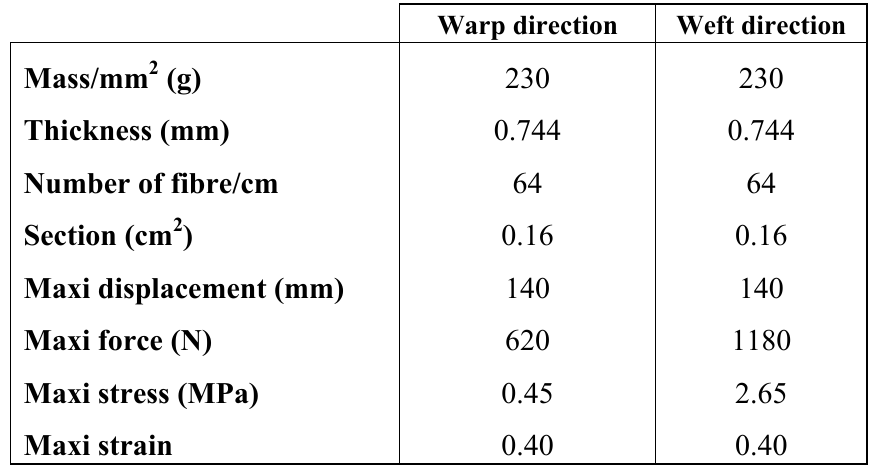
Table 2. Mechanical parameters of the textile fabric.